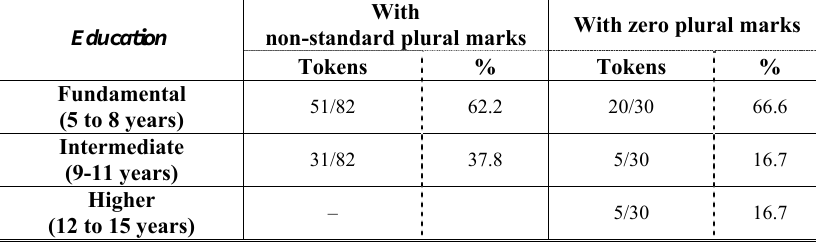
Table IX: Non-standard and absence of third person plural verbal marking in pre-verbal subject contexts and null subject and Education – Funchal